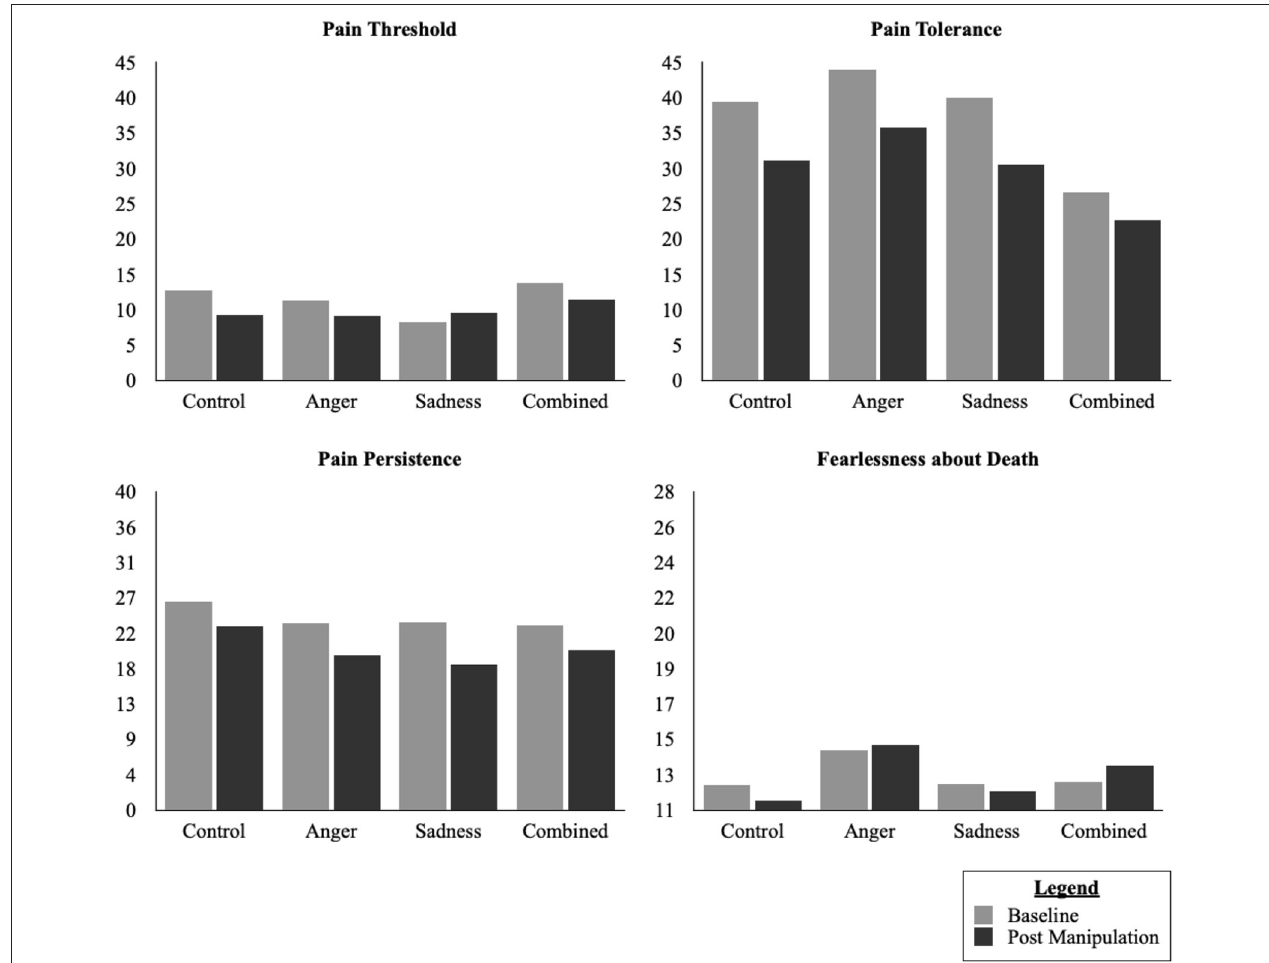
FIGURE 2 | Changes in pain responses and fearlessness of death in Study